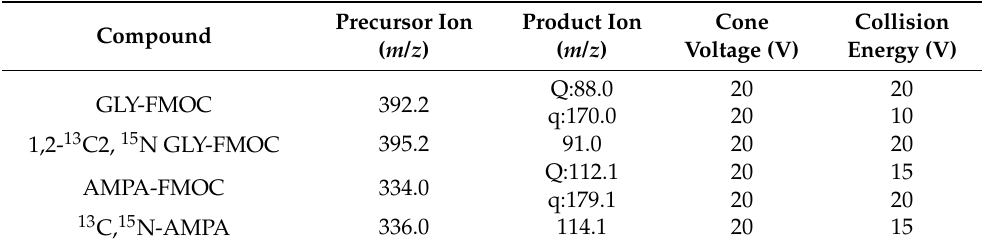
Table 1. Multiple reaction monitoring (MRM) transitions, cone voltages and collision energies for each used compound. Precursor Ion Product Ion Compound ( m / z ) ( m / z